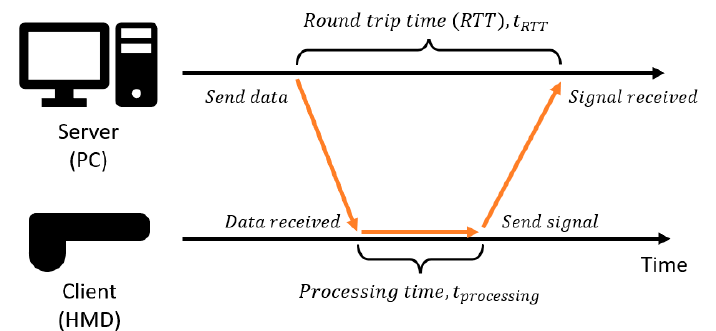
Figure 6. The overall process of the proposed framework.